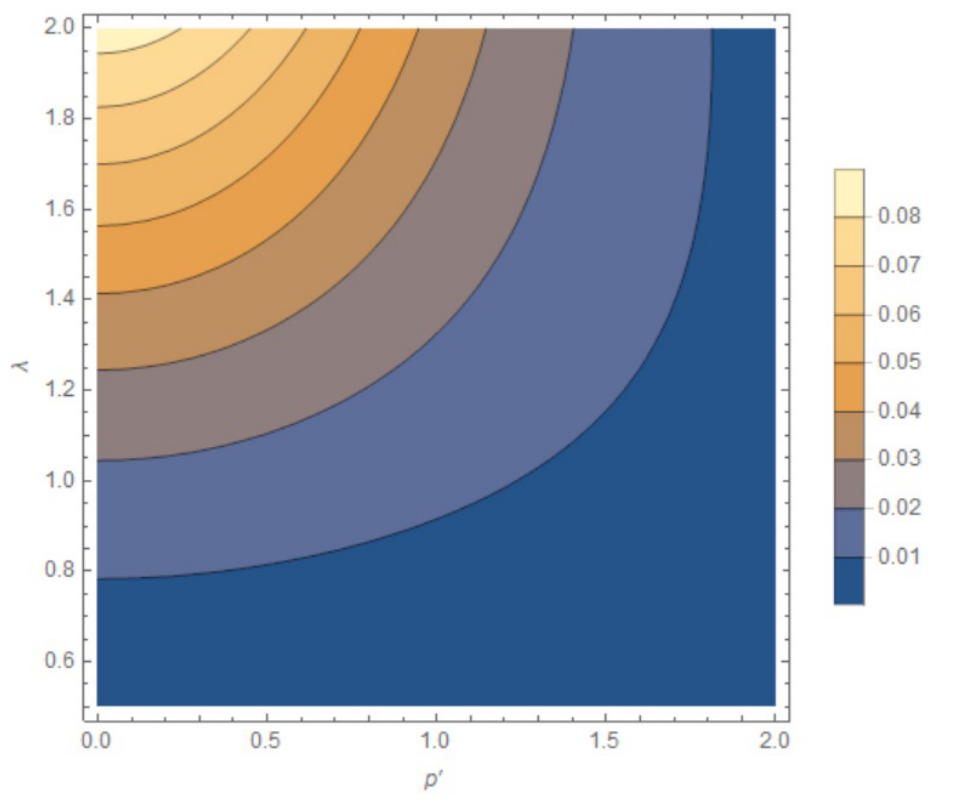
Figure 11. Probability density function for a free subluminal Lorentzian particle as function of p (cid:48) and λ